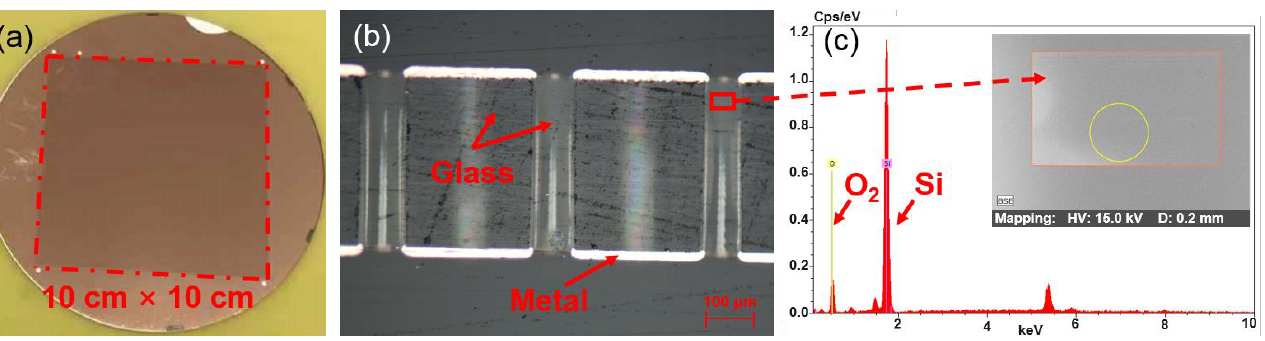
Figure 8. GEM prototype ( a ) Photograph of the GEM sample, where 10 cm × 10 cm is the effective functional area. ( b ) Cross-sectional view of the sample by an optical microscope. ( c ) In-hole composition detection by EDS (energy dispersive spectroscopy).